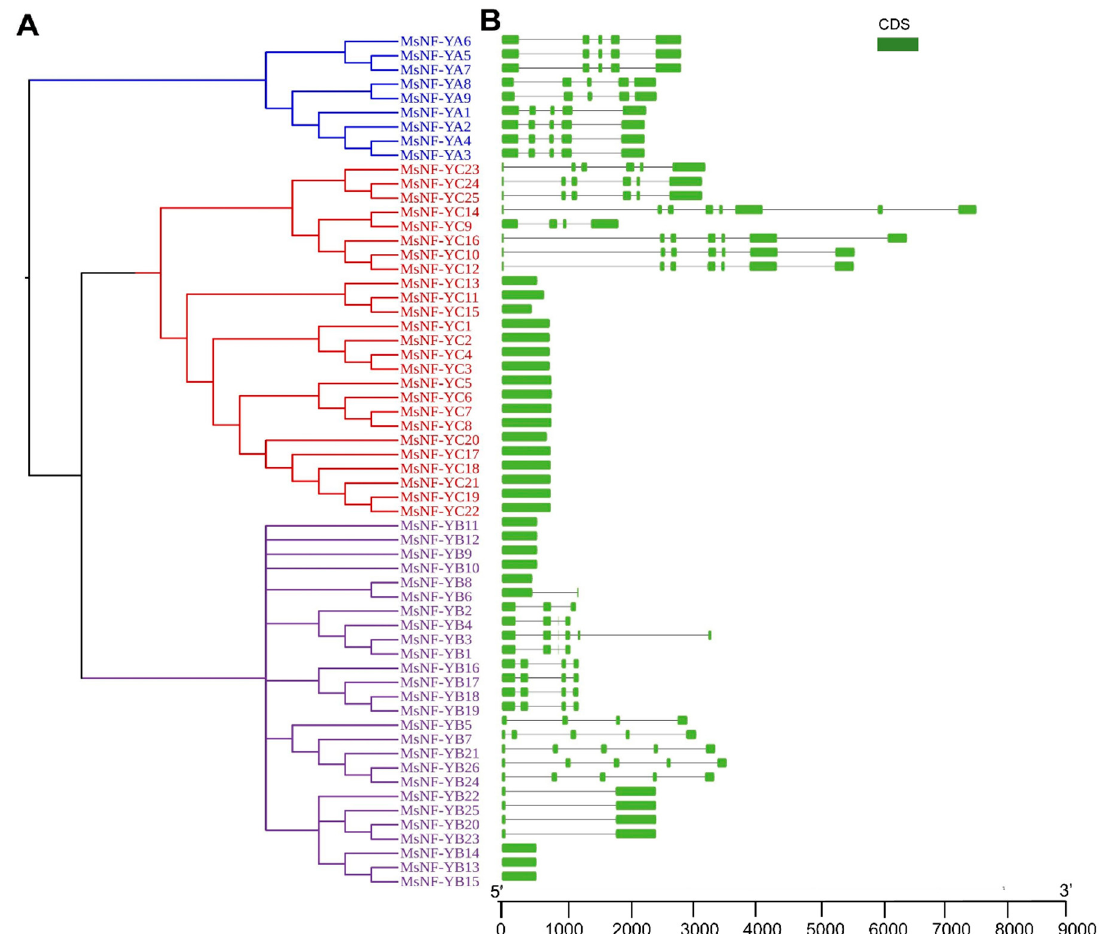
Figure 3. Phylogenetic analysis and gene structure of MsNF-Y genes. ( A ) Phylogenetic tree of MsNF- Ys; ( B ) Gene structure of alfalfa NF-Y genes. The green box indicates exons, and the black lines indicate introns.